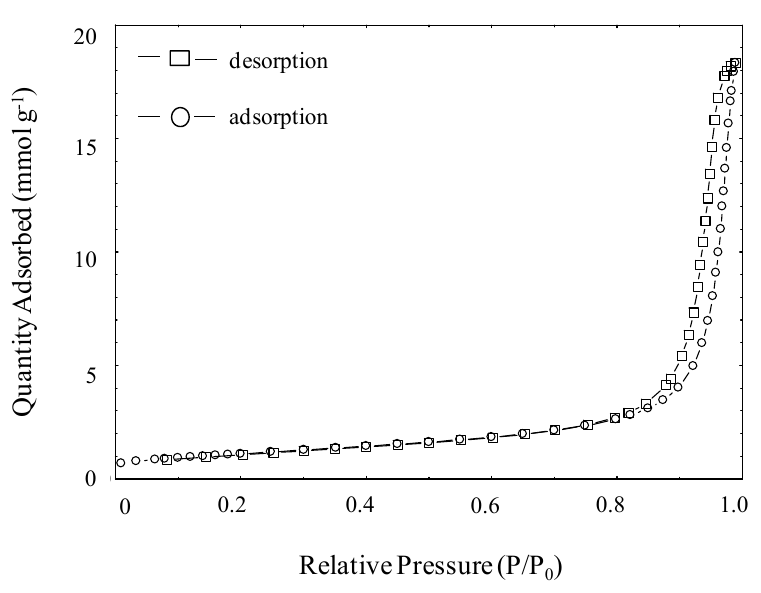
Figure 4. N 2 adsorption–desorption isotherms of the washed immobilized TiO 2 /PEG (TP2).